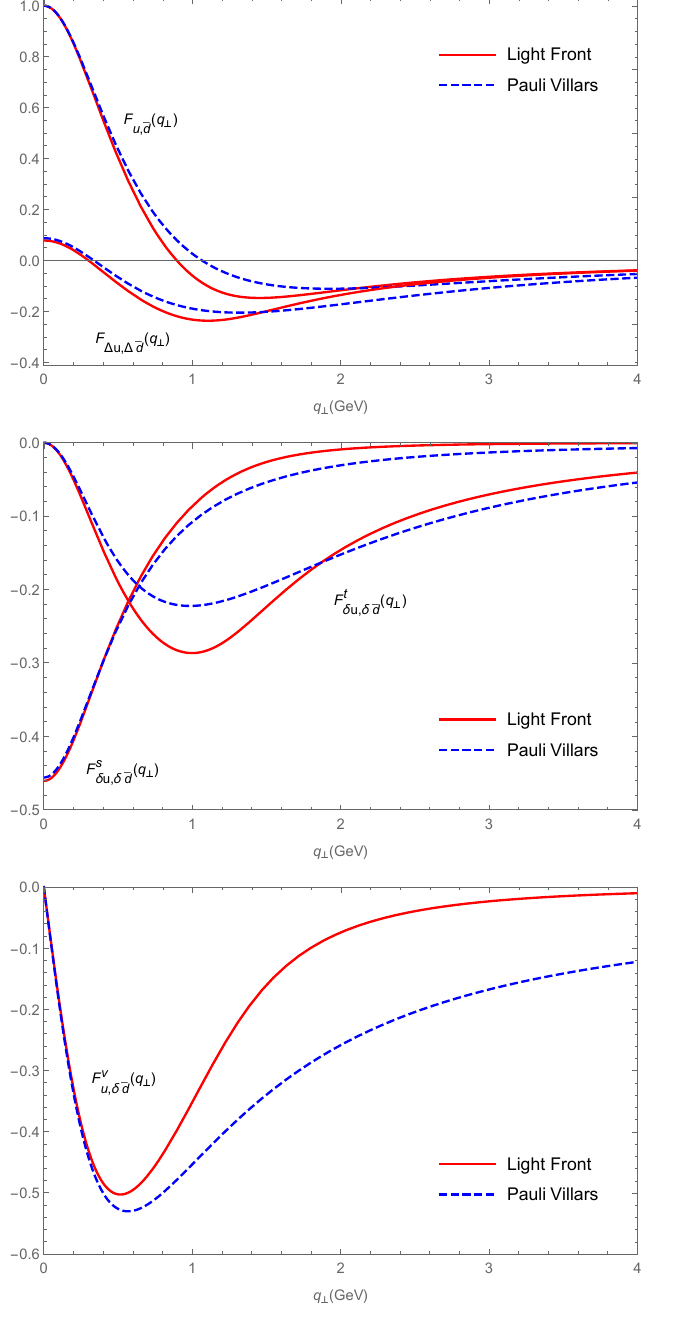
Figure 2 . Double parton distribution functions in the NJL model, in momentum space, inte- grated over x 1 ; x 2 . Dashed (full) curves represent results obtained using the Pauli-Villars (Light- Front) regularization method. Top panel: quantities obtained integrating F ( x 1 ; x 2 ; q ? ), eq. (2.22) u; (cid:22) d (eq. (2.32)) and F ( x 1 ; x 2 ; q ? ), eq. (2.23) (eq. (2.33)); central panel: quantities obtained in- (cid:1) u; (cid:1)(cid:22) d tegrating F s ( x 1 ; x 2 ; q ? ), eq. (2.25) (eq. (2.35)) and F t ( x 1 ; x 2 ; q ? ), eq. (2.26) (eq. (2.36)); (cid:14)u;(cid:14) (cid:22) d (cid:14)u;(cid:14) (cid:22) d bottom panel: the quantity obtained integrating F v ( x 1 ; x 2 ; q ? ), eq. (2.27) (eq. (2.37)). u;(cid:14) (cid:22) d